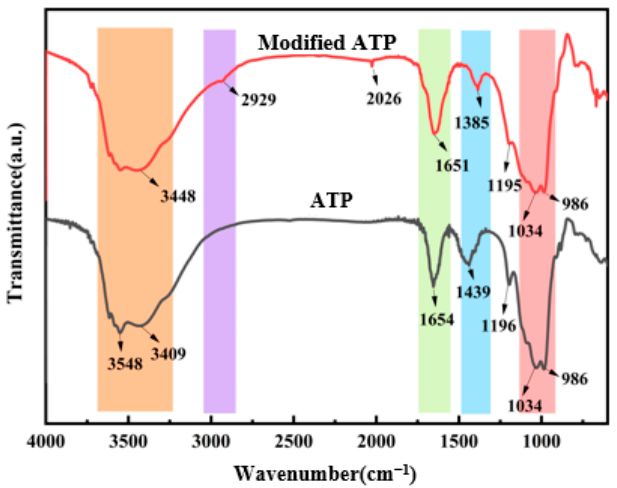
Figure 1. FTIR spectra of ATP before and after modification.